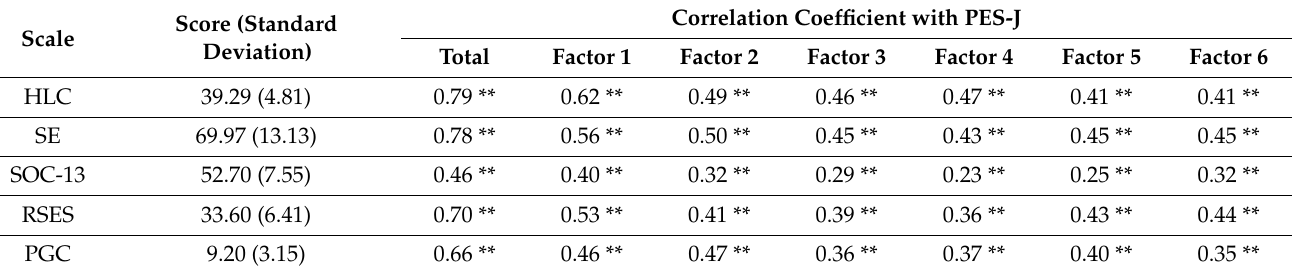
Table 5. Criteria-related validity of the 37-item